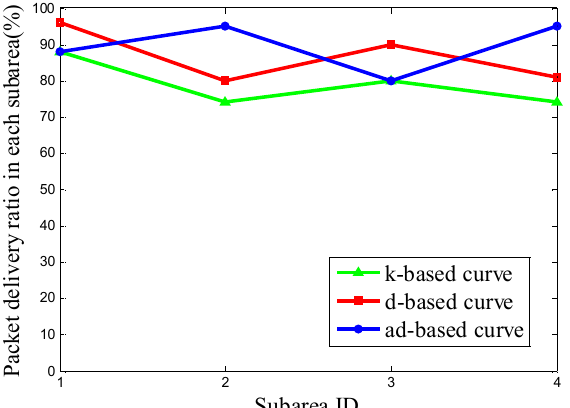
Figure 12. The PDR of k-based, d-based and adjustable d-based curve in node deployment (b) in Scenario 2.